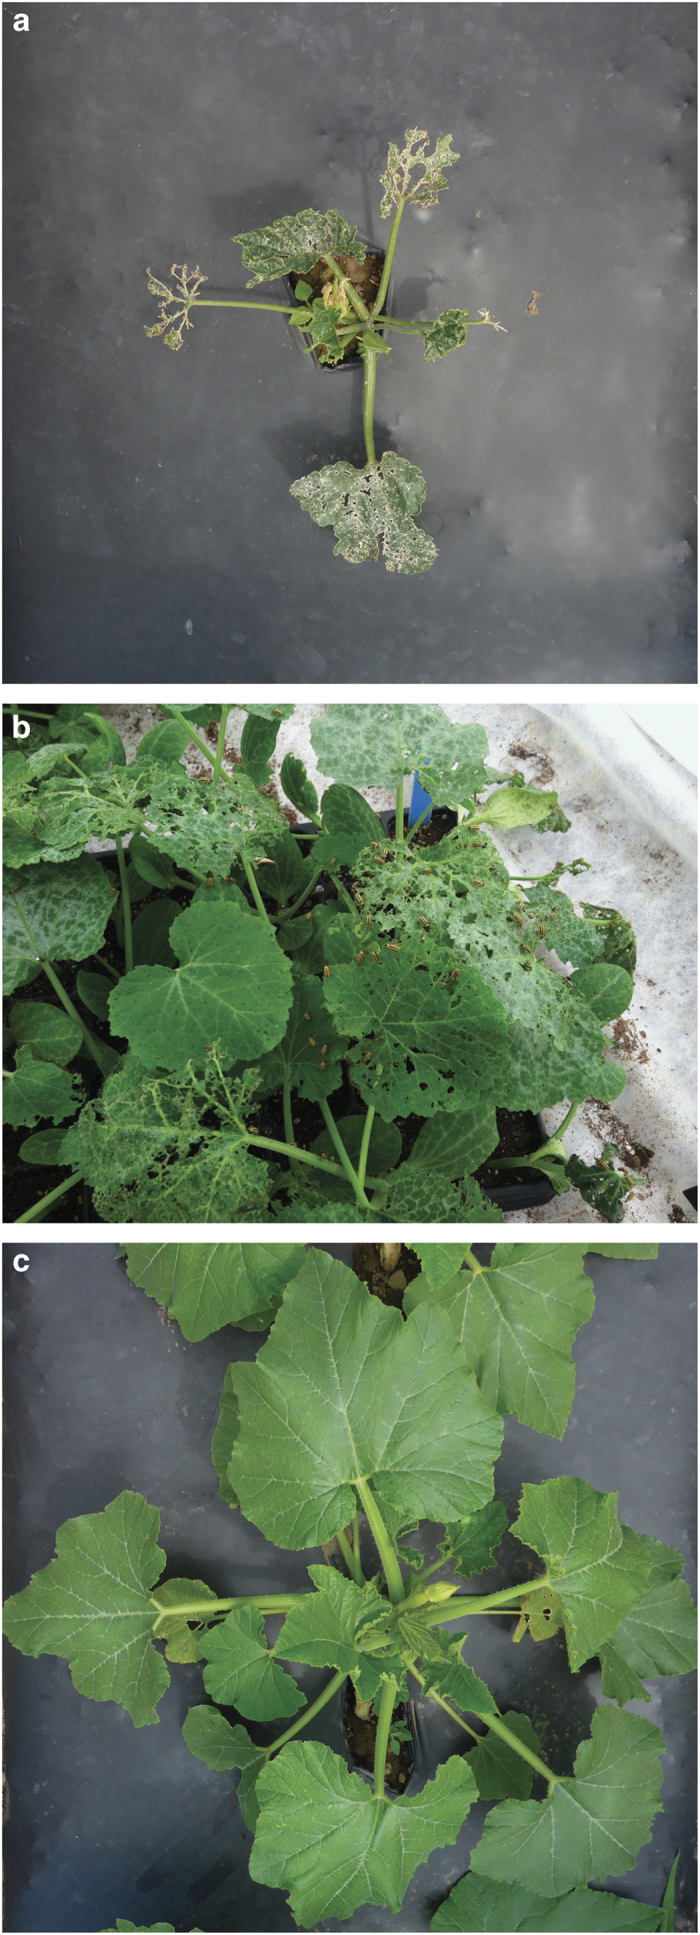
A comparison of adjacent young transplants in the field highlights the impact of striped cucumber beetle preference on plant health. C. pepo subsp. pepo cultivar ‘Golden Zucchini’ (a) is highly preferred and incurs substantial damage as the beetles aggregate and feed (b), whereas the non-preferred C. pepo subsp. texana cultivar ‘Success PM’ (c) is nearly free of herbivory damage.